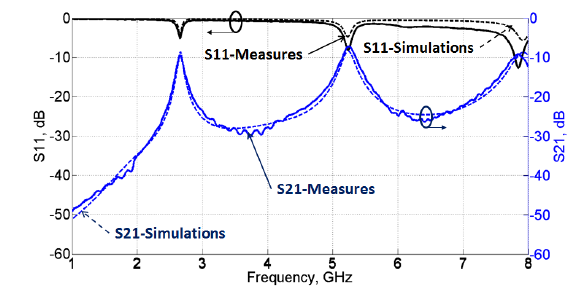
Figure 5: S-parameters from measurements (plain lines) and simulations (dotted lines) in “empty” test case from 1 GHz to 8 GHz.